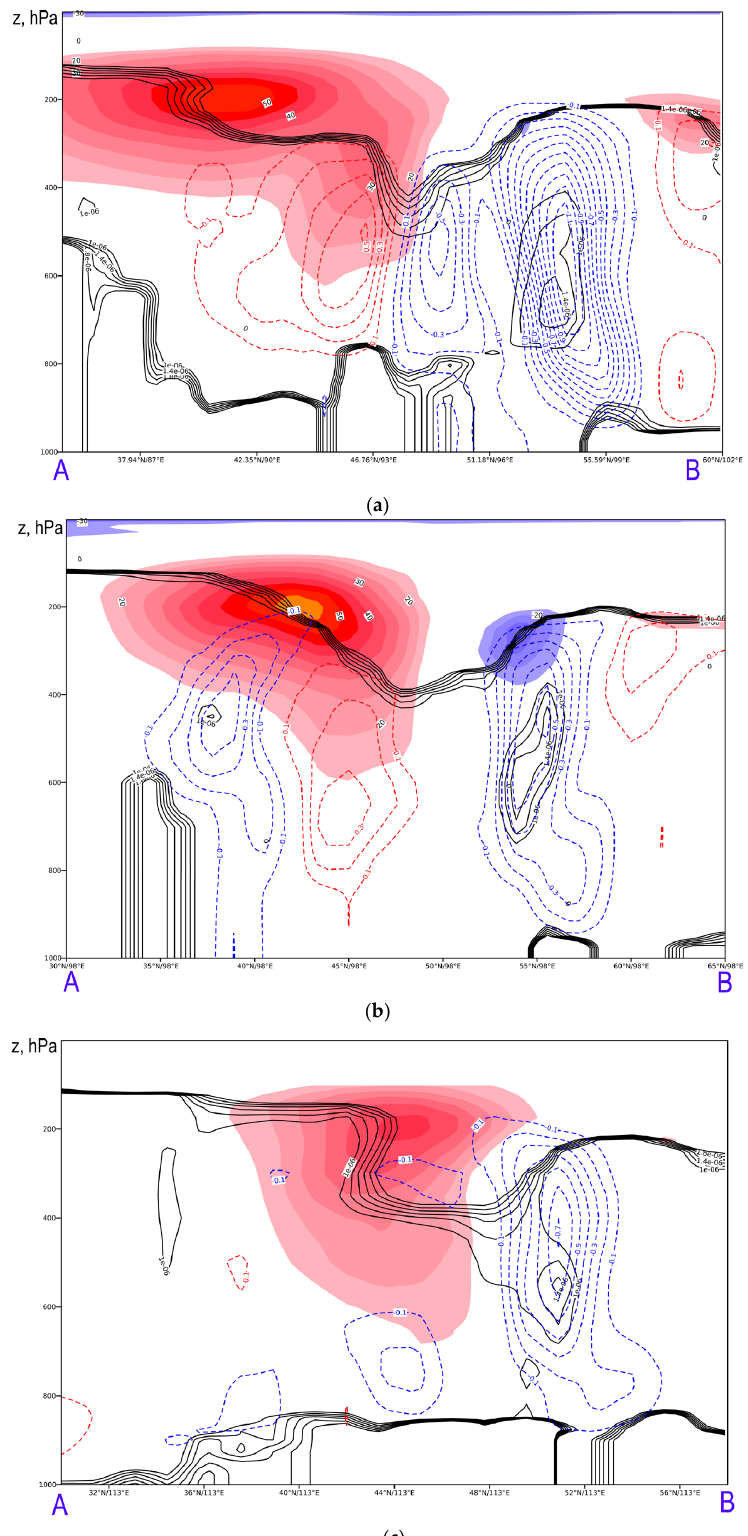
Figure 7. Cross-sections of horizontal wind speed (m/s) (blue and red fill), PV (PVU) (black lines) and vertical speed (Pa/s) (red and blue dashed lines) for 24 June 18 UTC ( а ), 25 June 12 UTC ( b ) and 27 July 12 UTC ( c ), letters A and B in Figure 6. The negative value for vertical velocity—ascending motions. Red shading—westerly wind (positive); blue—easterly wind (negative). Era-Interim data.